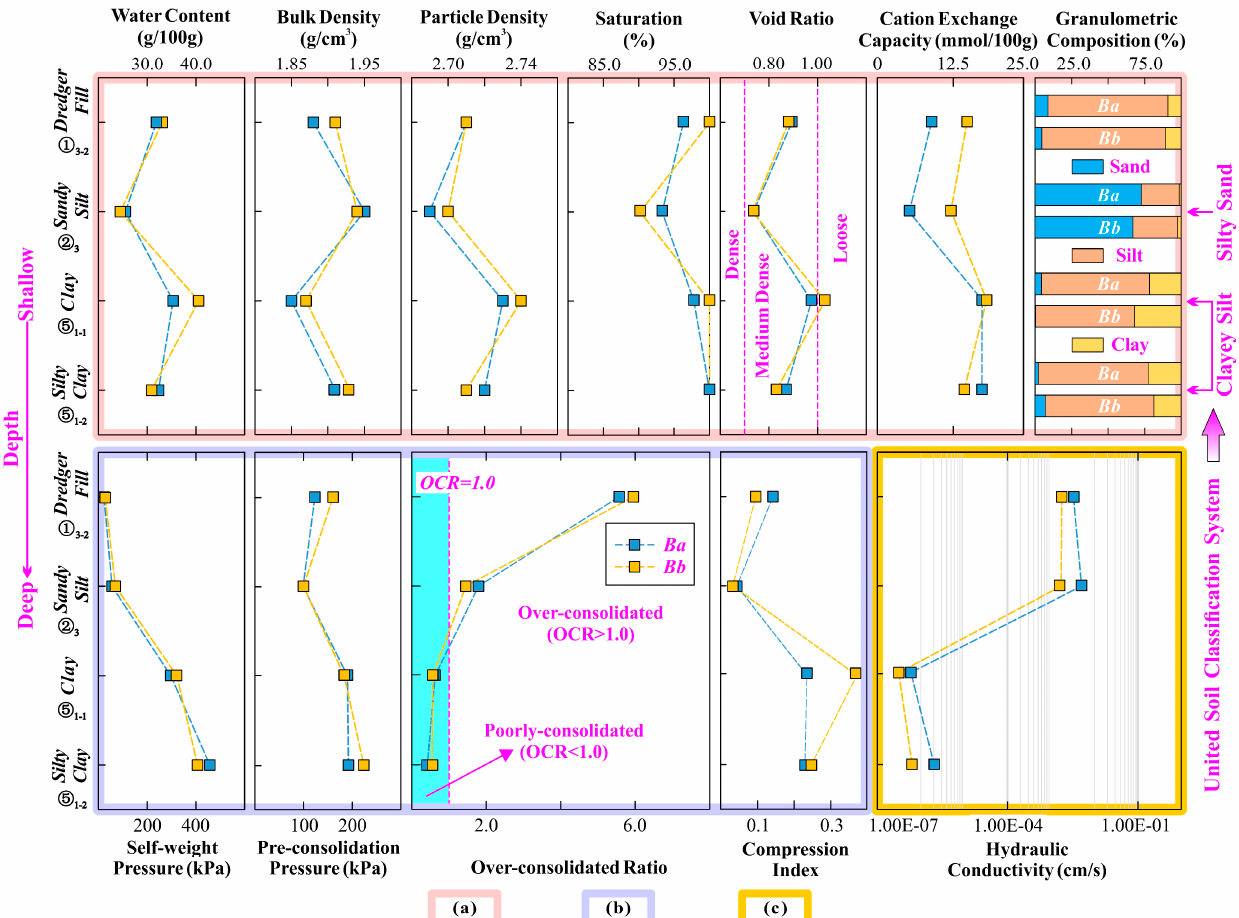
Figure 7. The geological features of the soil layers around Ba and Bb boreholes. ( a ) Basic Properties, ( b ) compressibility, and ( c ) permeability. Note that according to the United Soil Classification System, the ② 3 Sandy Silt, ⑤ 1-1 Clay, and ⑤ 1-2 Silty Clay could also be named as silty sand, clayey silt, and clayey silt, respectively. In order to ensure the consistency of soil layers and to facilitate the description, the soil classification in the results and discussion section still uses the soil type (Figure 3) that was determined by the geological age, soil behavior, and physical and mechanical properties.